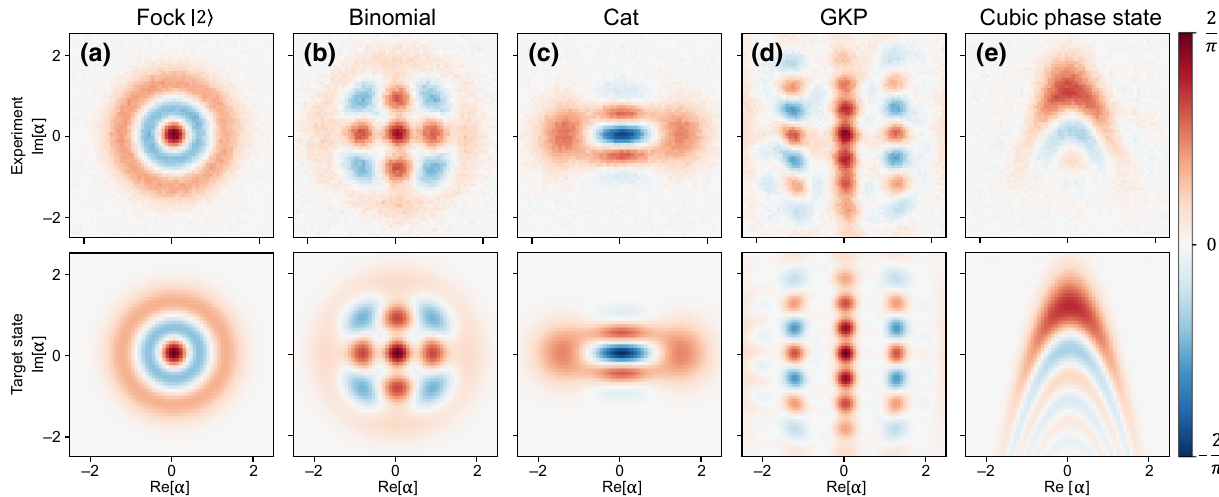
FIG. 2. Wigner functions of the states created by optimized SNAP-displacement gates. Top row: experimental data. Bottom row: target states. (a) Two-photon Fock state | 2 (cid:4) , (b) binomial state ( | 0 (cid:4) + | 4 (cid:4) )/ and λ the normalization constant. These three states have two photons on average and are created with two SNAP gates and three displacements. Next, (d) the GKP state with four photons on average and (e) the cubic phase state. The GKP state is prepared with three SNAP gates and four displacements and the cubic phase state is prepared with three SNAP gates and three displacements. Corresponding fidelities are listed in Table I.